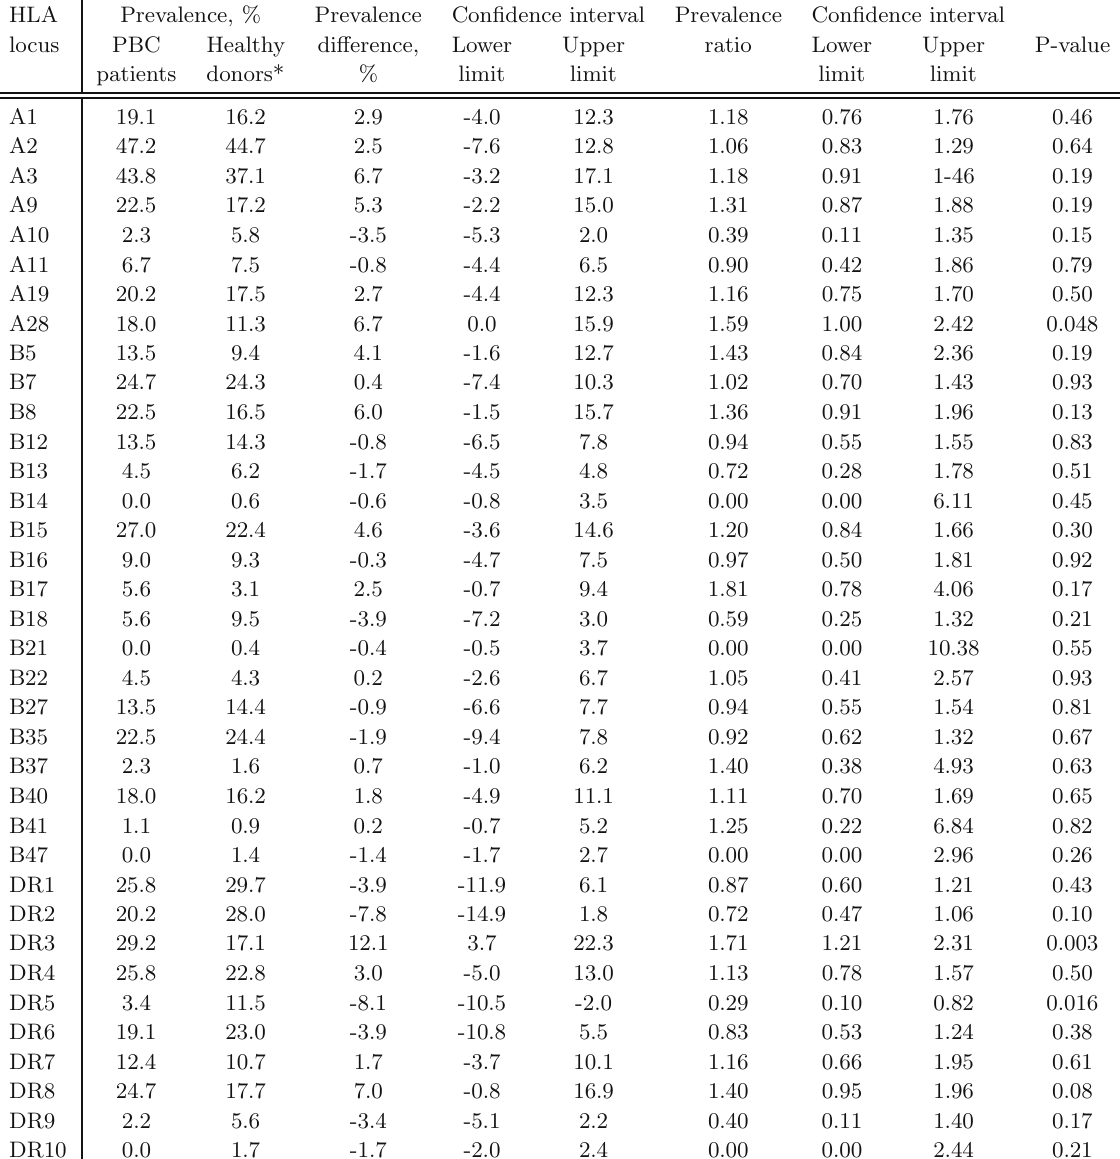
Table 1B Comparison of observed HLA-A,HLA-B and HLA-DR prevalences in a popu- lation sample of healthy Finnish bone marrow donors and Finnish liver transplantation patients due to primary biliary cirrhosis (PBC) in terms of the prevalence difference and prevalence ratio as well the associated large-sample significance probabilities (2-sided P- values) and 95% confidence intervals (lower and upper limits). Comparisons involving zero prevalences in both series are